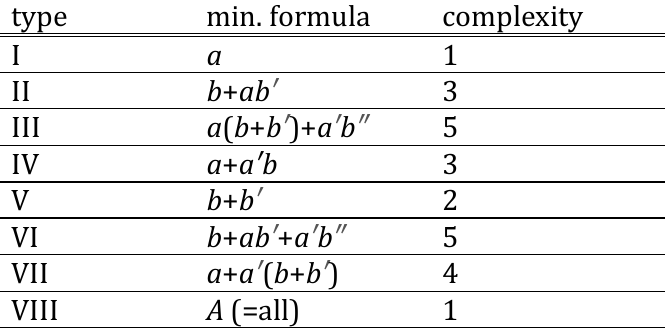
Table 1: The minimal formulas and logical complexities of the eight types from Fig.